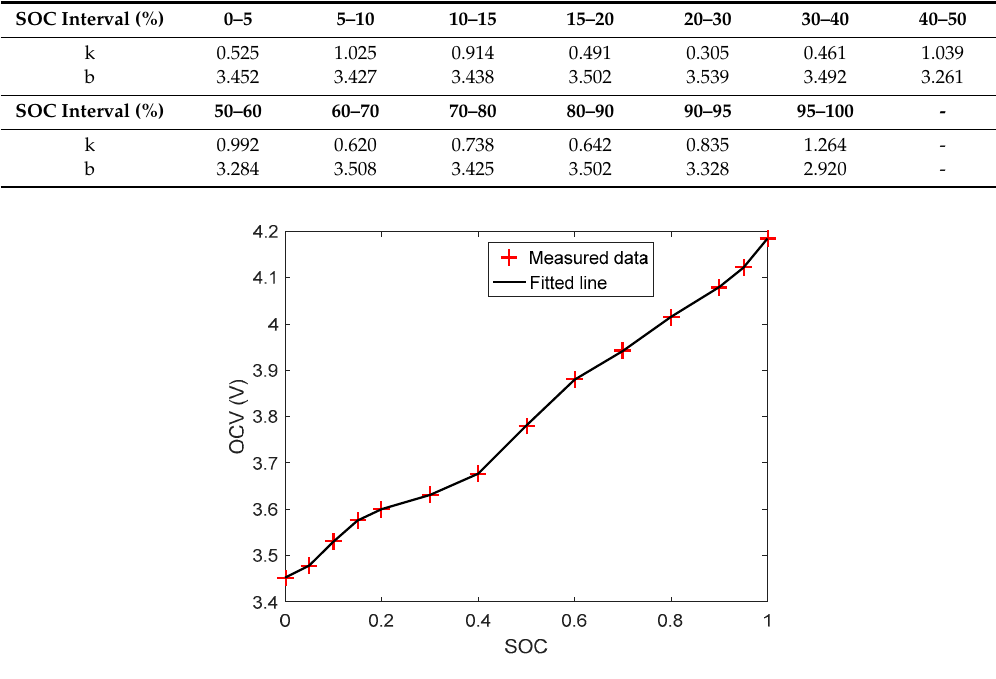
Figure 3. Measured and fitted OCV vs. SOC.